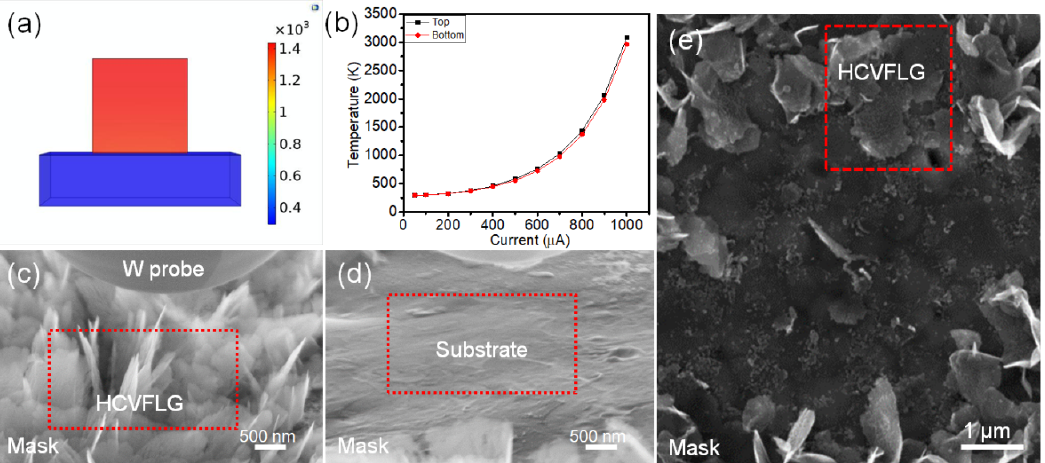
Figure 7. ( a ) Simulation results of the temperature distribution of HCVFLG during field emission. ( b ) Simulation results of the temperature at top and bottom of HCVFLG under different emission current. SEM images of HCVFLG before vacuum breakdown ( c ) and after vacuum breakdown ( d ). ( e ) SEM image of HCVFLG film after field emission test. Red rectangle in ( c ) and ( d ) shows the same area.